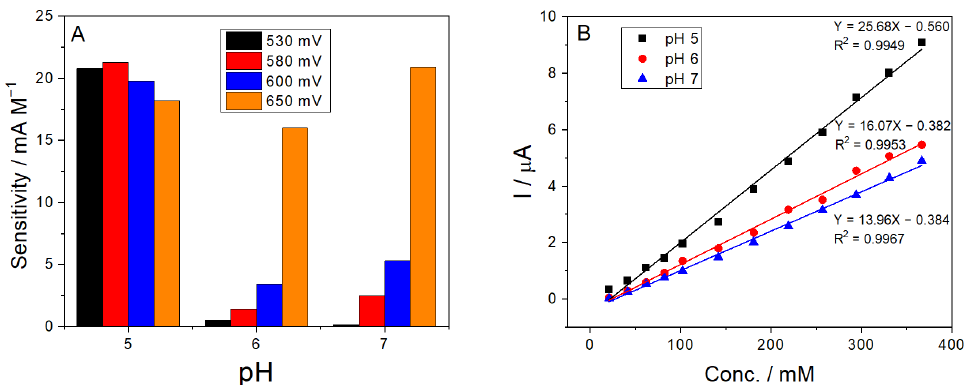
Figure 11. ( A ) Variation of the sensitivity with pH and applied working potentials for MWCNT-CS/SPE sensors. ( B ) Calibration curves for the amperometric detection of nitrite in acetate buffer, 0.1 M, pH 5, at an applied potential of 0.58 V, and in PBS, pH 6 and 7, at 0.68